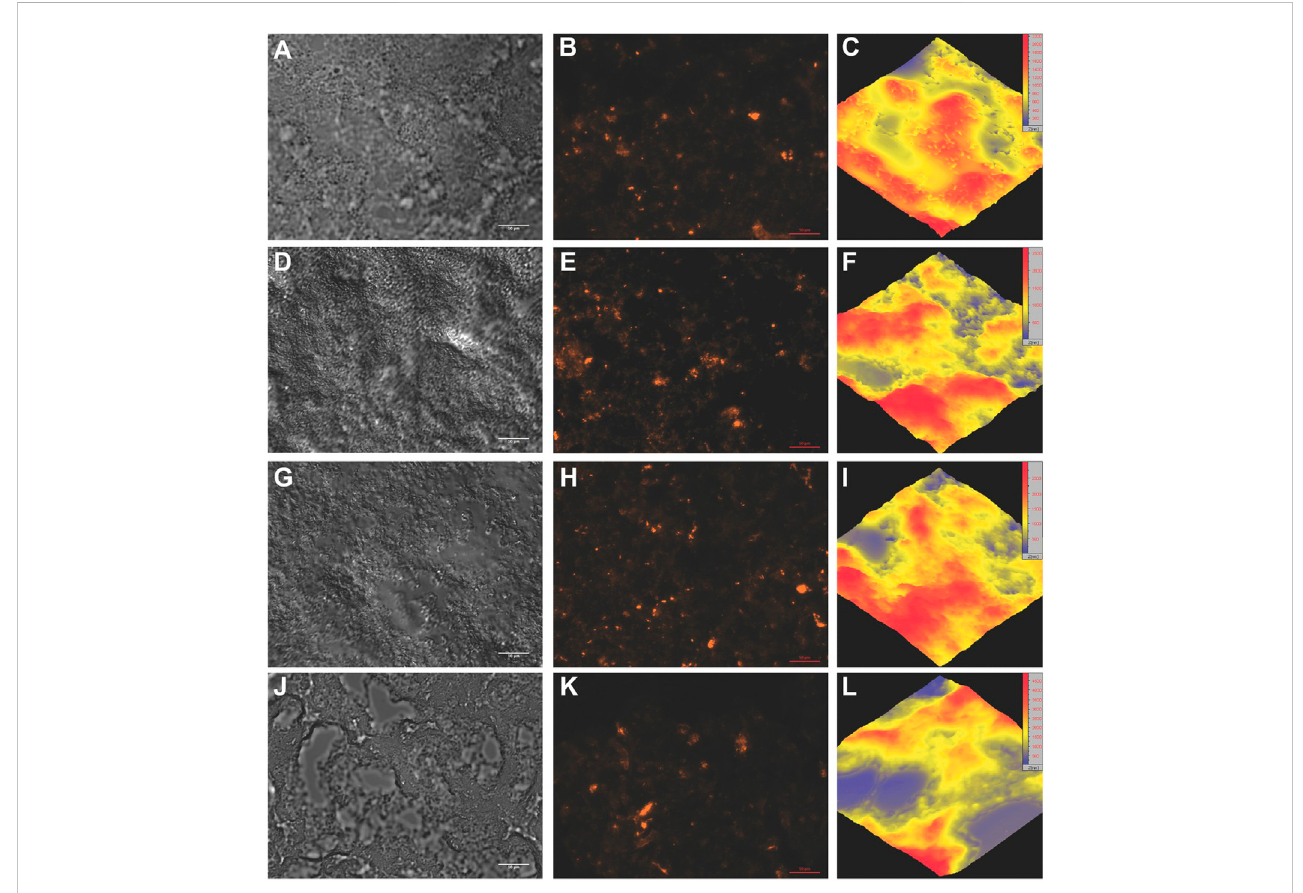
Microscopic evaluation of the microgel-based scaffold morphology and spacing within the scaffold. The images of the hydrated scaffolds were utilized to visualize the morphology of these scaffolds by DIC, fl uorescence, and atomic force microscopy. Top row = 5 mg mL − 1 PEG-VS, second row = 10 mg mL − 1PEG-VS,thirdrow=20 mgmL − 1PEG-VS,bottomrow=40 mgmL − 1PEG-VS. (A,D,G,J) Individual microgelscanbediscernedwithinthescaffolds,but are clustered into a structure, leaving gaps in the scaffold. This structure became more evident with increasing crosslinker concentration, where larger spaces were seen throughout the sections. Scale bars are 10 μ m. (B,E,H,K) Homogeneous collagen distribution was con fi rmed by incorporating fl uorescent collagen. No differences were seen with respect to crosslinker concentration. The images displaying the collagen are the fl uorescent version of (A,D,G,J)